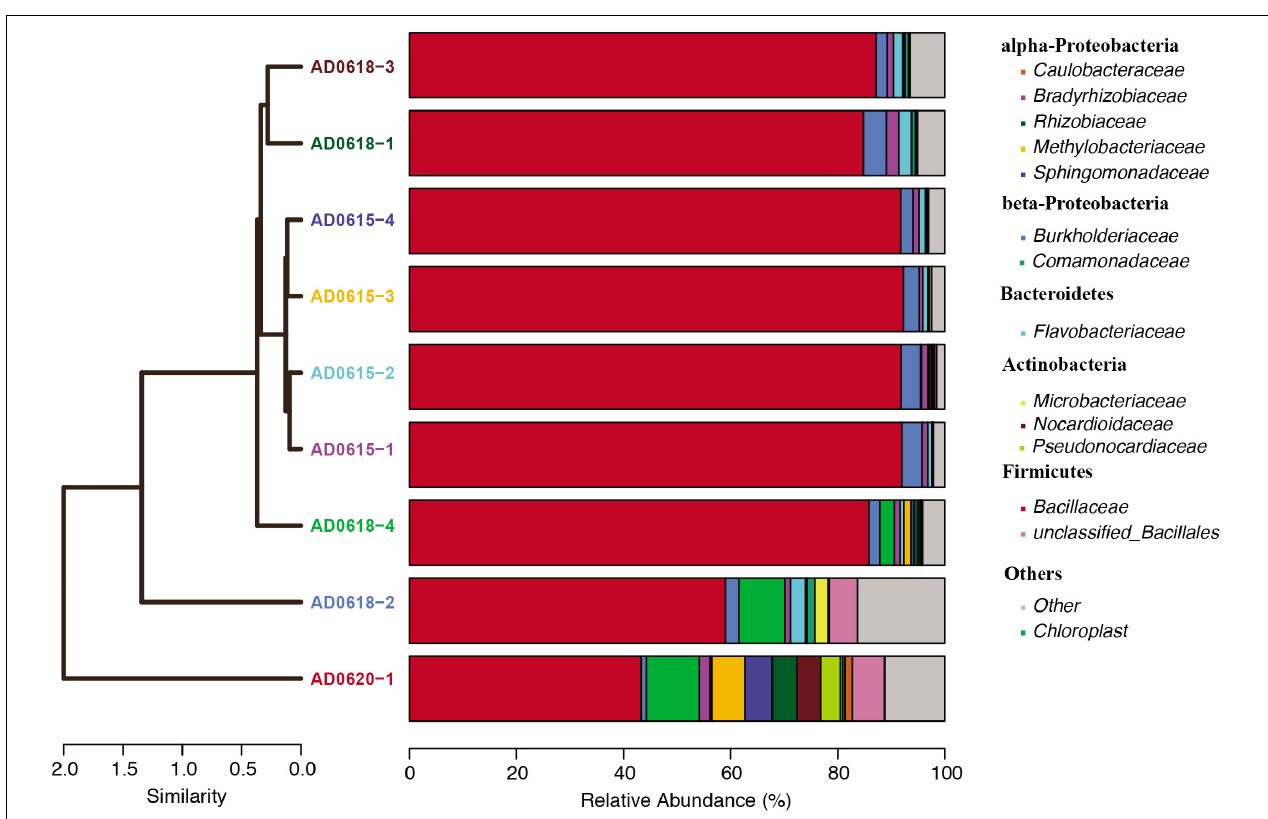
FIGURE 4 | Relative abundance of bacterial lineages plotted for each accession. The cluster analyses illustrated the similarity among lineages visualized as a tree, whereas the relative abundance blocks visualized the proportion of each major bacterial lineage recovered. Color code showed on the right side.